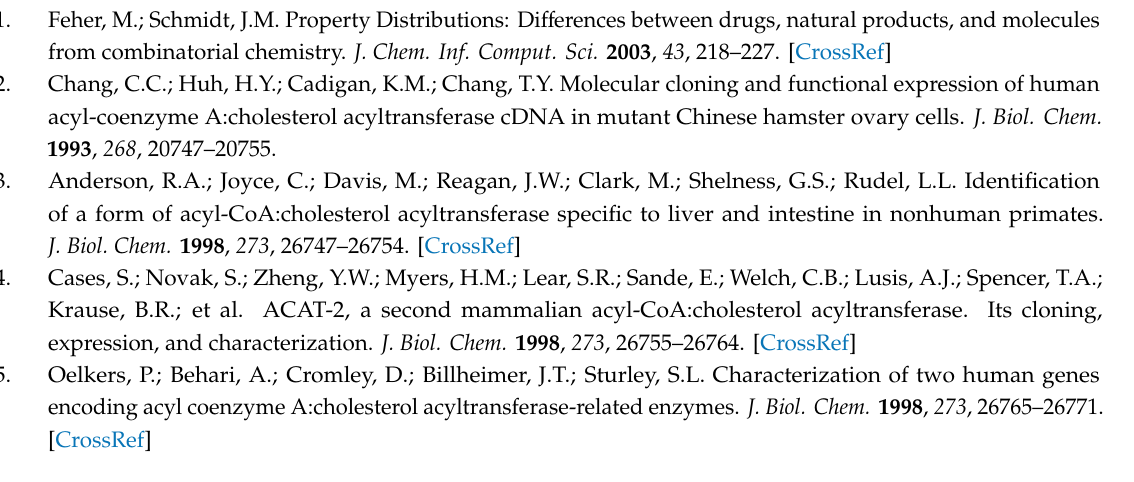
Supplementary Materials: The following are available online, Figures S1–S24: NMR spectra of 1 – 3 , Table S1: NMR chemical shifts of 2 in CDCl 3